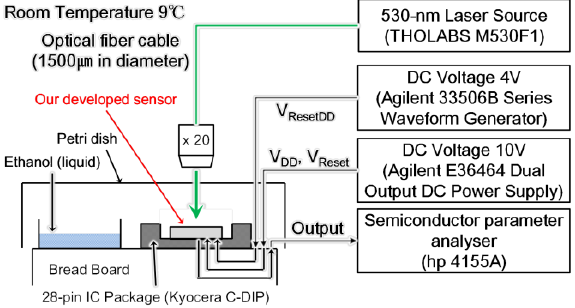
Figure 6. Schematic diagram of the experimental set up.